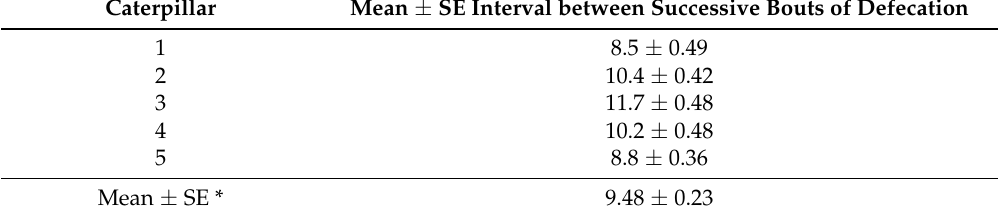
Table 5. Interval between successive episodes of defecation for five first instar caterpillars of Cactoblastis cactorum . N = 35 successive episodes for each caterpillar.